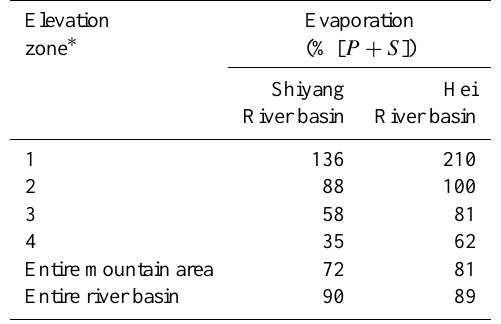
Table 5. Evaporation as a percentage of the annual sum of di- rect rainfall ( P ) and snowmelt volumes ( S ) for individual elevation zones and mountain area within the Shiyang and Hei river basins and for the entire river basin, respectively. Percentages are based on 10-year sums.